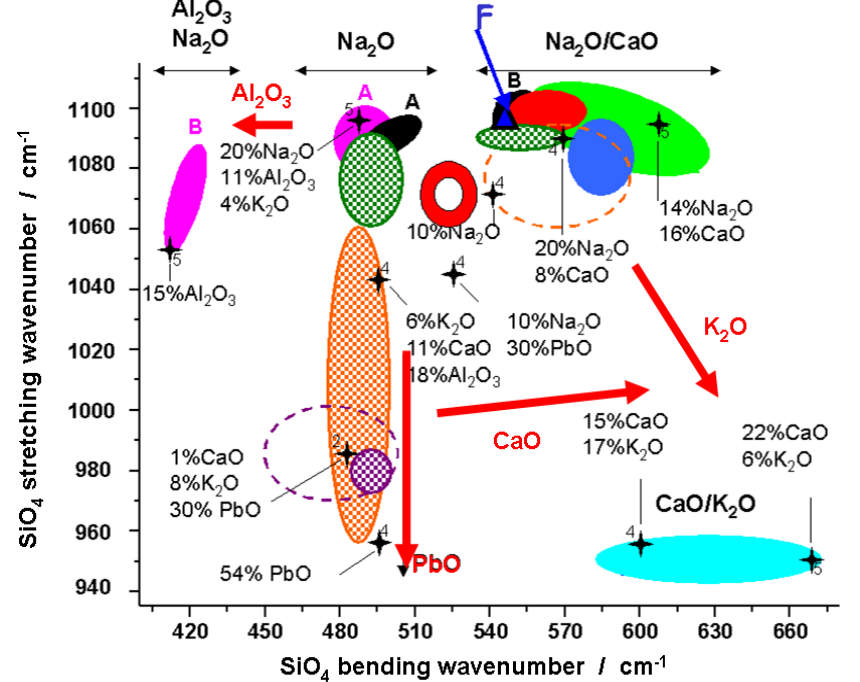
6. Case Studies: White, Blue, Yellow, Green, Red, and Black Pigments and Coloring